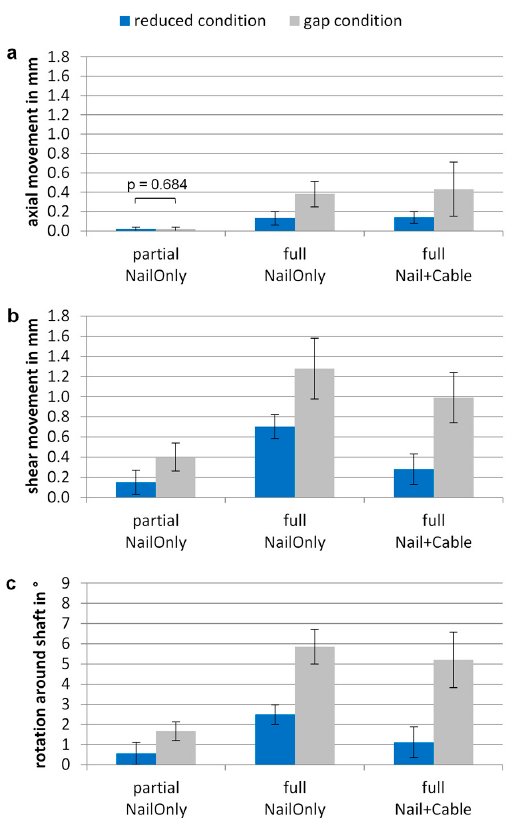
Figure 2. Interfragmentary motion under quasi-static partial and full weight-bearing loads for a well-reduced fracture condition and for a gap condition. Differences between NailOnly group and Nail + Cable group are shown for ( a ) axial movement in mm; ( b ) shear movement in mm and ( c ) rotation around the shaft axis in °. Values are given as mean ± standard deviation. Movements in the gap condition were significantly larger ( p ≤ 0.018) compared to the reduced condition, if not otherwise indicated.